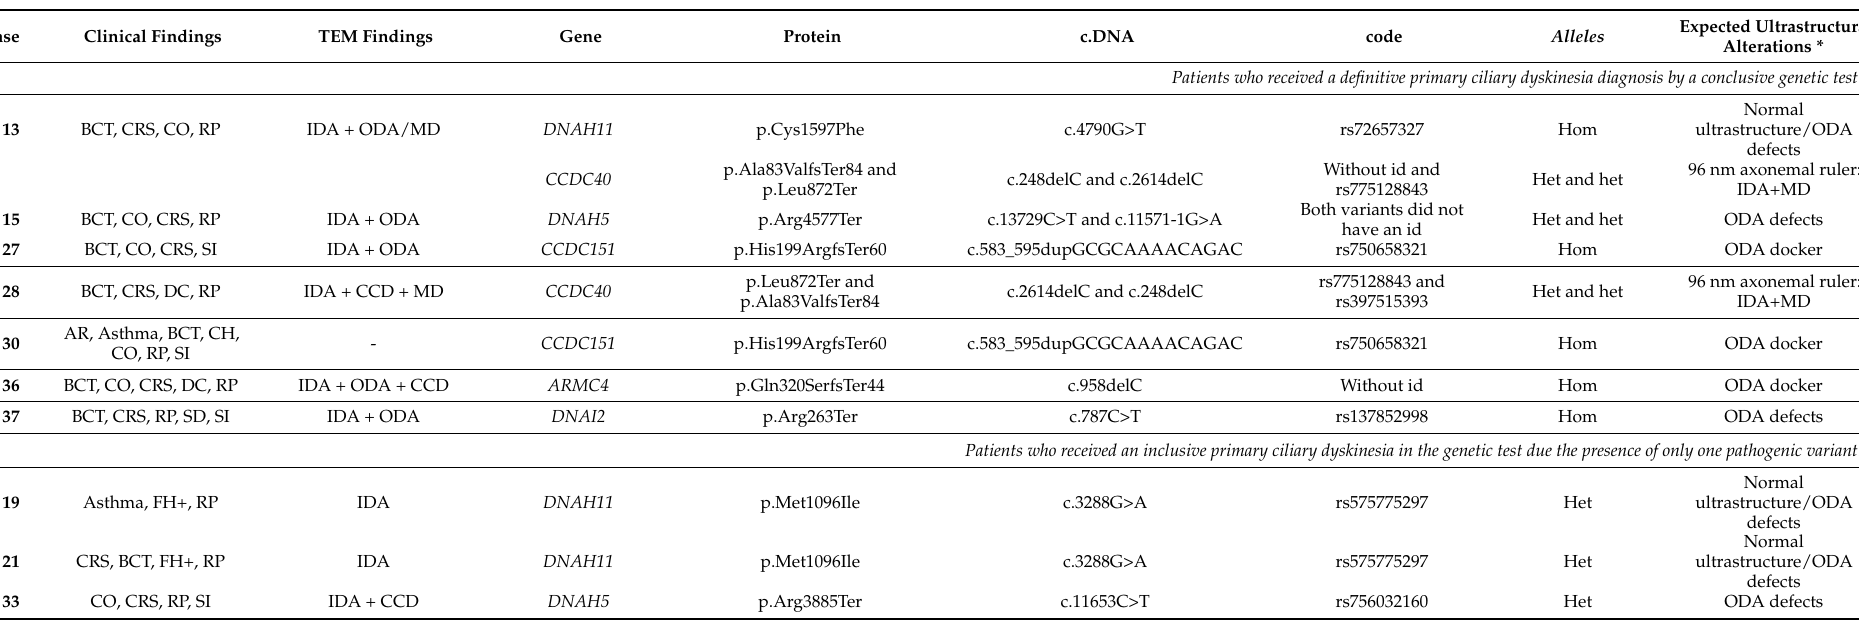
Table 4. Individuals with genetic variants positive for primary ciliary dyskinesia, their clinical and transmission electron microscopy